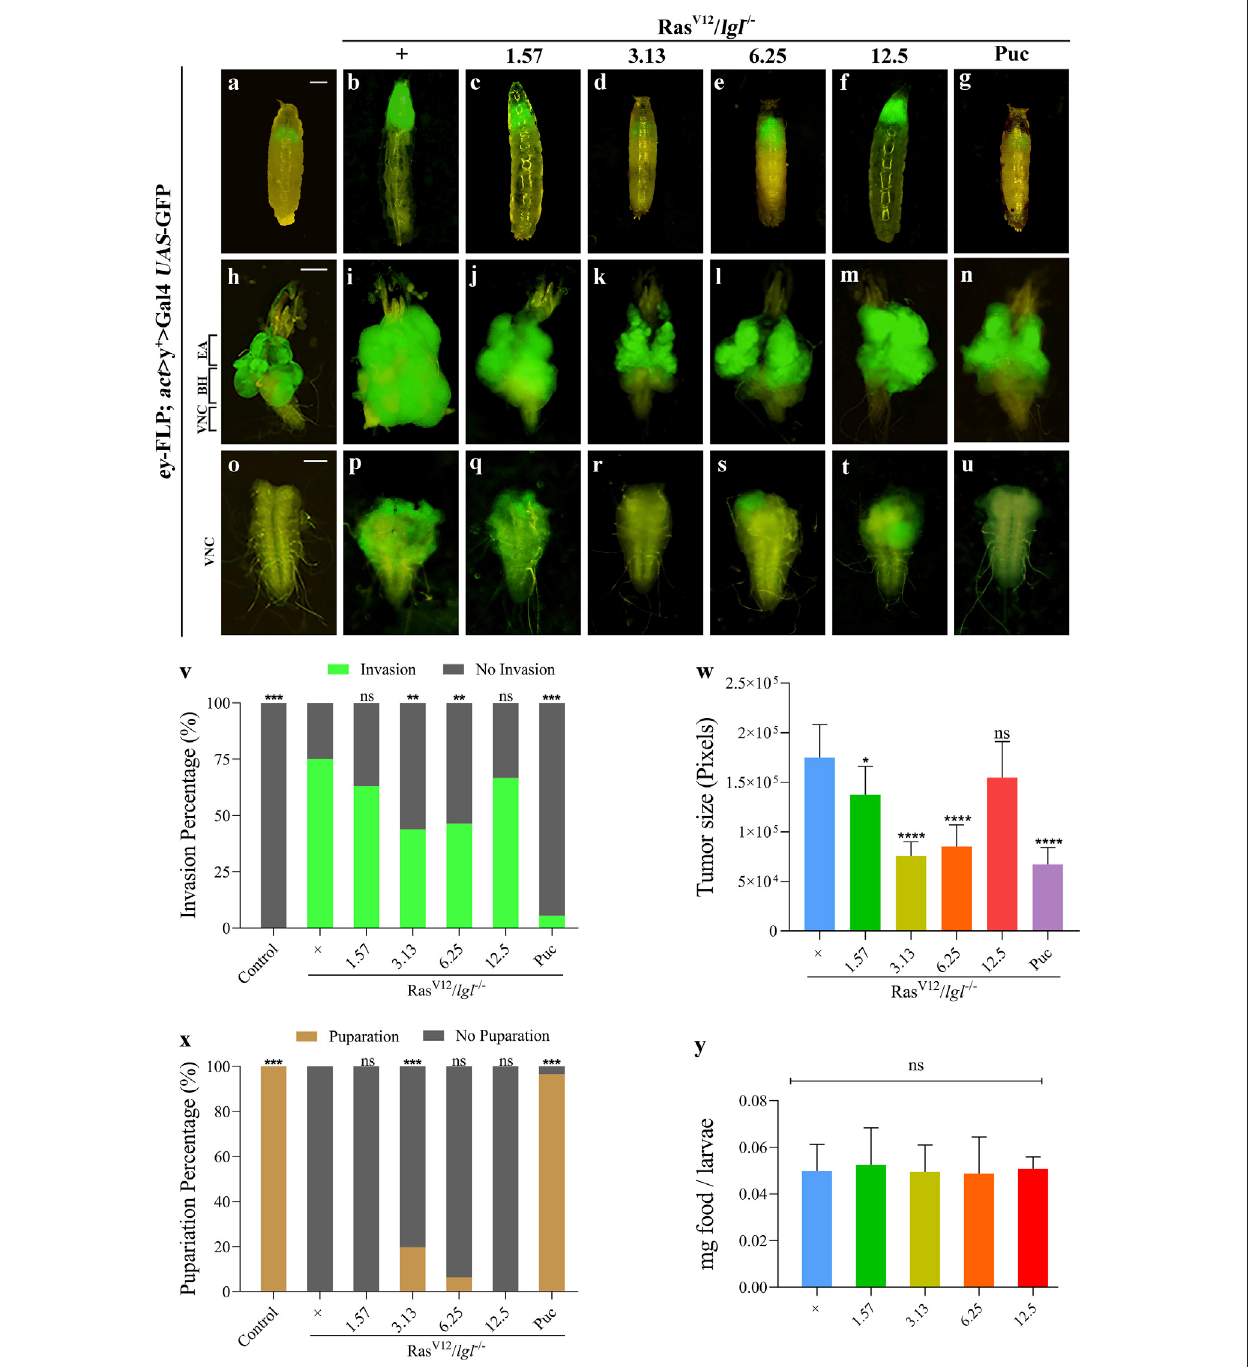
FIGURE 6 | XFZYD inhibits tumour invasion in Drosophila VNC. Fluorescent images showing Drosophila larval whole body (A – G) , cephalic complexes (H – N) , and ventralnervecords[VNC, (O – U) ];theanteriorisupinallpanels.Statisticalanalysisoftheinvasionpercentage (V) isshownin fi gures (O – U) [ (O) ,0%, n =50; (P) ,75%, n = 44; (Q) , 63%, n = 46; (R) 43.9%, n = 57; (S) , 46.5%, n = 43; (T) , 66.7%, n = 45; (U) , 5.5%, n = 55]. The histogram of tumour size (W) is shown in fi gures (I – N) , and is measured in pixels by Image-Pro Plus 6.0 ( n = 10). Stacked bar graph of the pupariation percentage (X) is shown in fi gures (A – G) [ (A) , 100%, n = 50; (B) , 0%, n = 51; (C) , 0%, n = 52; (D) 19.67%, n = 61; (E) , 6.25%, n = 43; (F) , 0%, n = 45; (G) , 96.6%, n = 58]. (Y) Measurement of 20 min food intake by early third-instar larvae as calculated by blue food ingestion (6 – 8 larvae per pool, n = 3). For invasion and pupariation statistics, the chi-square test was applied. For tumour size and food intake statistics, one-way ANOVA with Bonferroni ’ s multiple comparison test was applied. Compared to the Ras V12 / lgl − / − group, **** p < 0.0001, *** p < 0.001, ** p < 0.01, * p < 0.05; ns, no signi fi cant difference. Scale bar: 500 µm (A – G) , 200 µm (H – N) and 100 µm (O – U) .